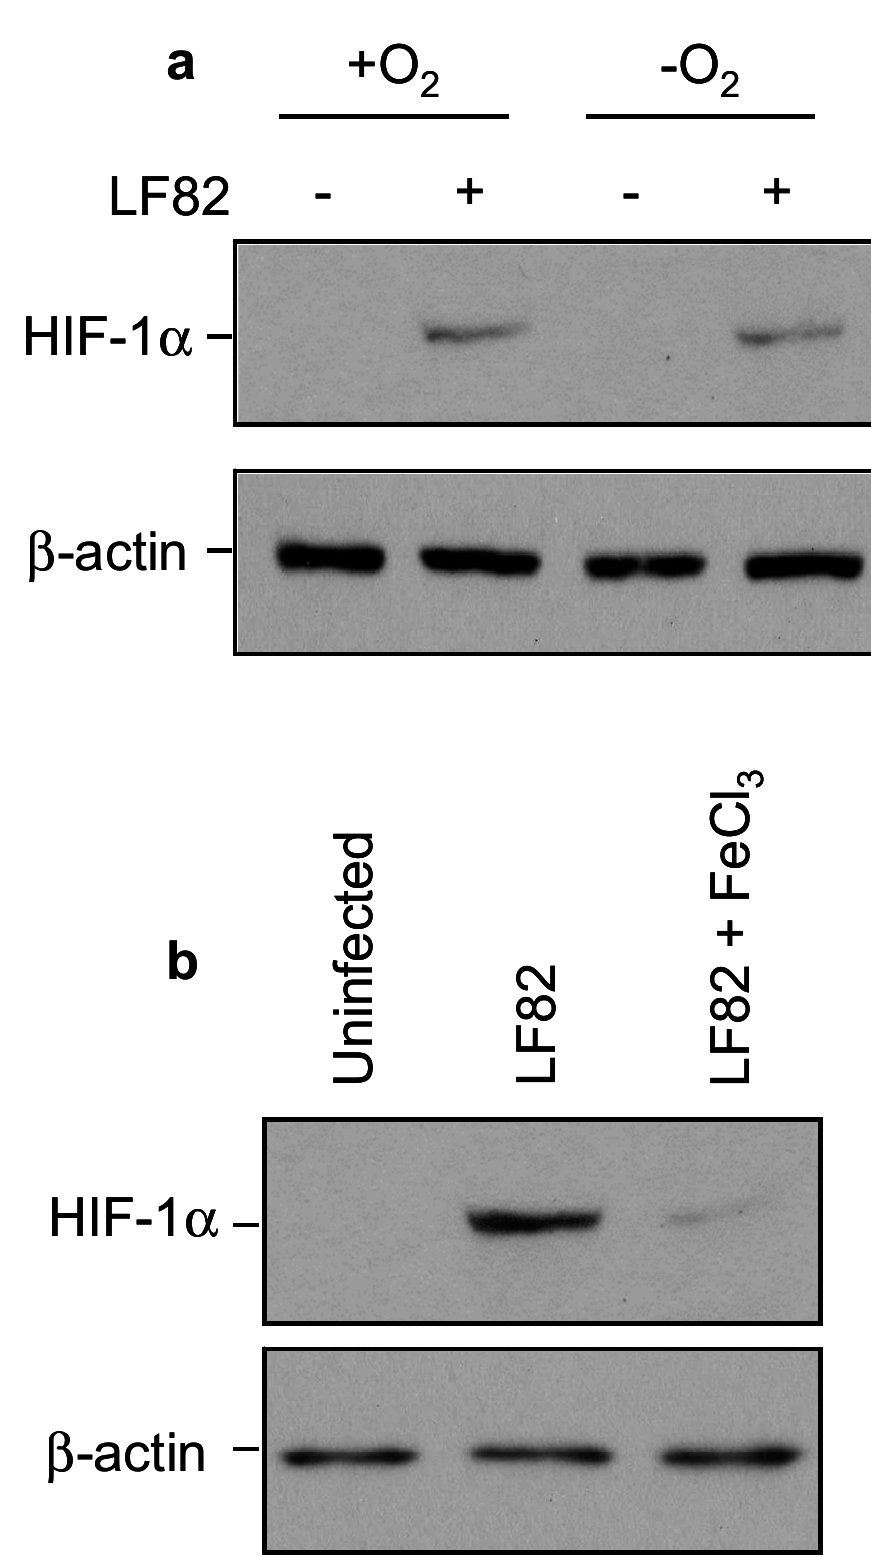
Figure 5. AIEC LF82 activates HIF-1 α by chelating iron rather than by inducing hypoxia. ( a ) T84 cells were grown on regular plastic ( − O 2 ) or gas-permeable (+O 2 ) dishes and then infected with the wild-type AIEC LF82 strain for 3 h, washed, and incubated with gentamicin for 3 h. HIF-1 α expression was assessed by Western blot. ( b ) T84 cells were grown on regular plastic and then infected with the wild-type LF82 strain as in ( a ) in normal culture conditions or in the presence of 200 µ M of FeCl 3 . HIF-1 α expression was assessed by Western blot. 2.7. HIF-1 α Controls AIEC Intracellular Replication by Modulating Host Autophagy Finally, we sought to investigate the functional impact of AIEC-induced HIF-1 α expression. To analyze the role of HIF-1 α in AIEC-induced autophagy, before infection, T84 cells were transfected with an siRNA directed against HIF-1 α mRNA or a scramble siRNA. As shown in Figure 6a, in cells transfected with the scramble siRNA, infection with LF82 induced HIF-1 α expression and autophagy, as shown by the increased LC3-II level. HIF-1 α siRNA inhibited LF82-induced HIF-1 α expression and subsequently sup- pressed autophagy activation